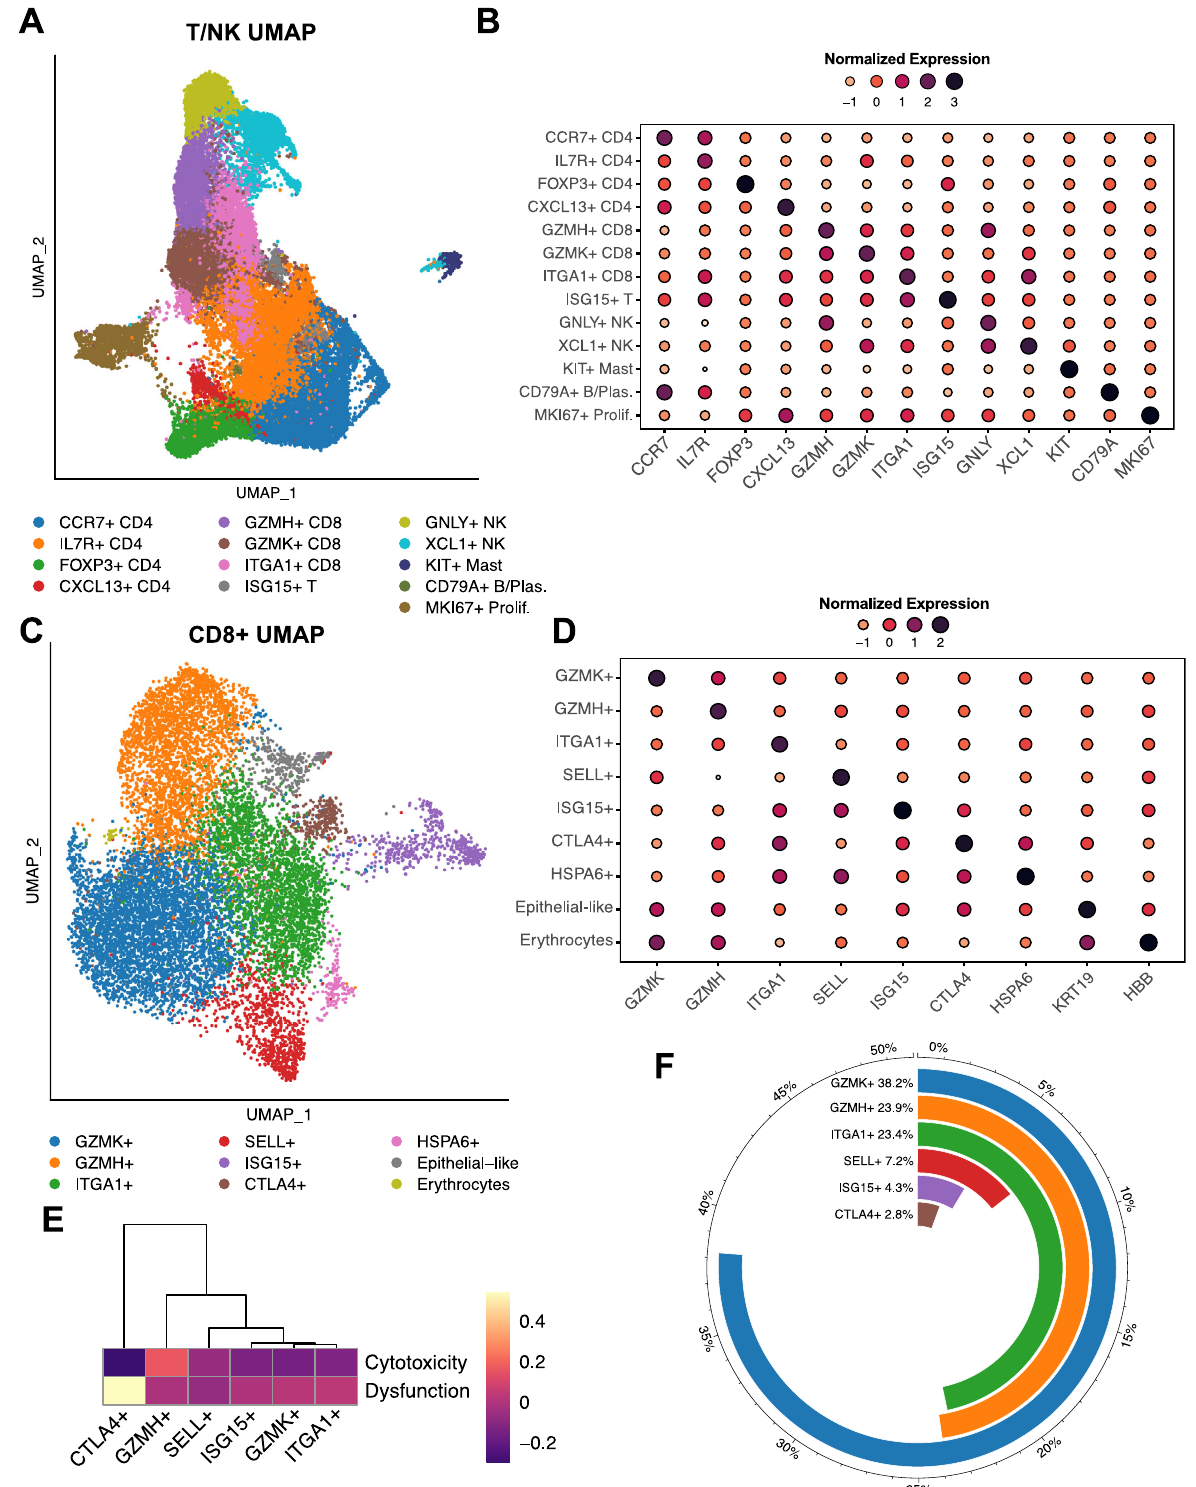
Fig. 4 | Charting the T/NK landscape in the PDAC tumor microenvironment. A UMAP overview of the T/NK compartment. NK natural killer, UMAP uniform manifold approximation and projection. B The most differentially expressed gene within each T/NK cluster. C UMAP of the more granular CD8 +T cell reclustering